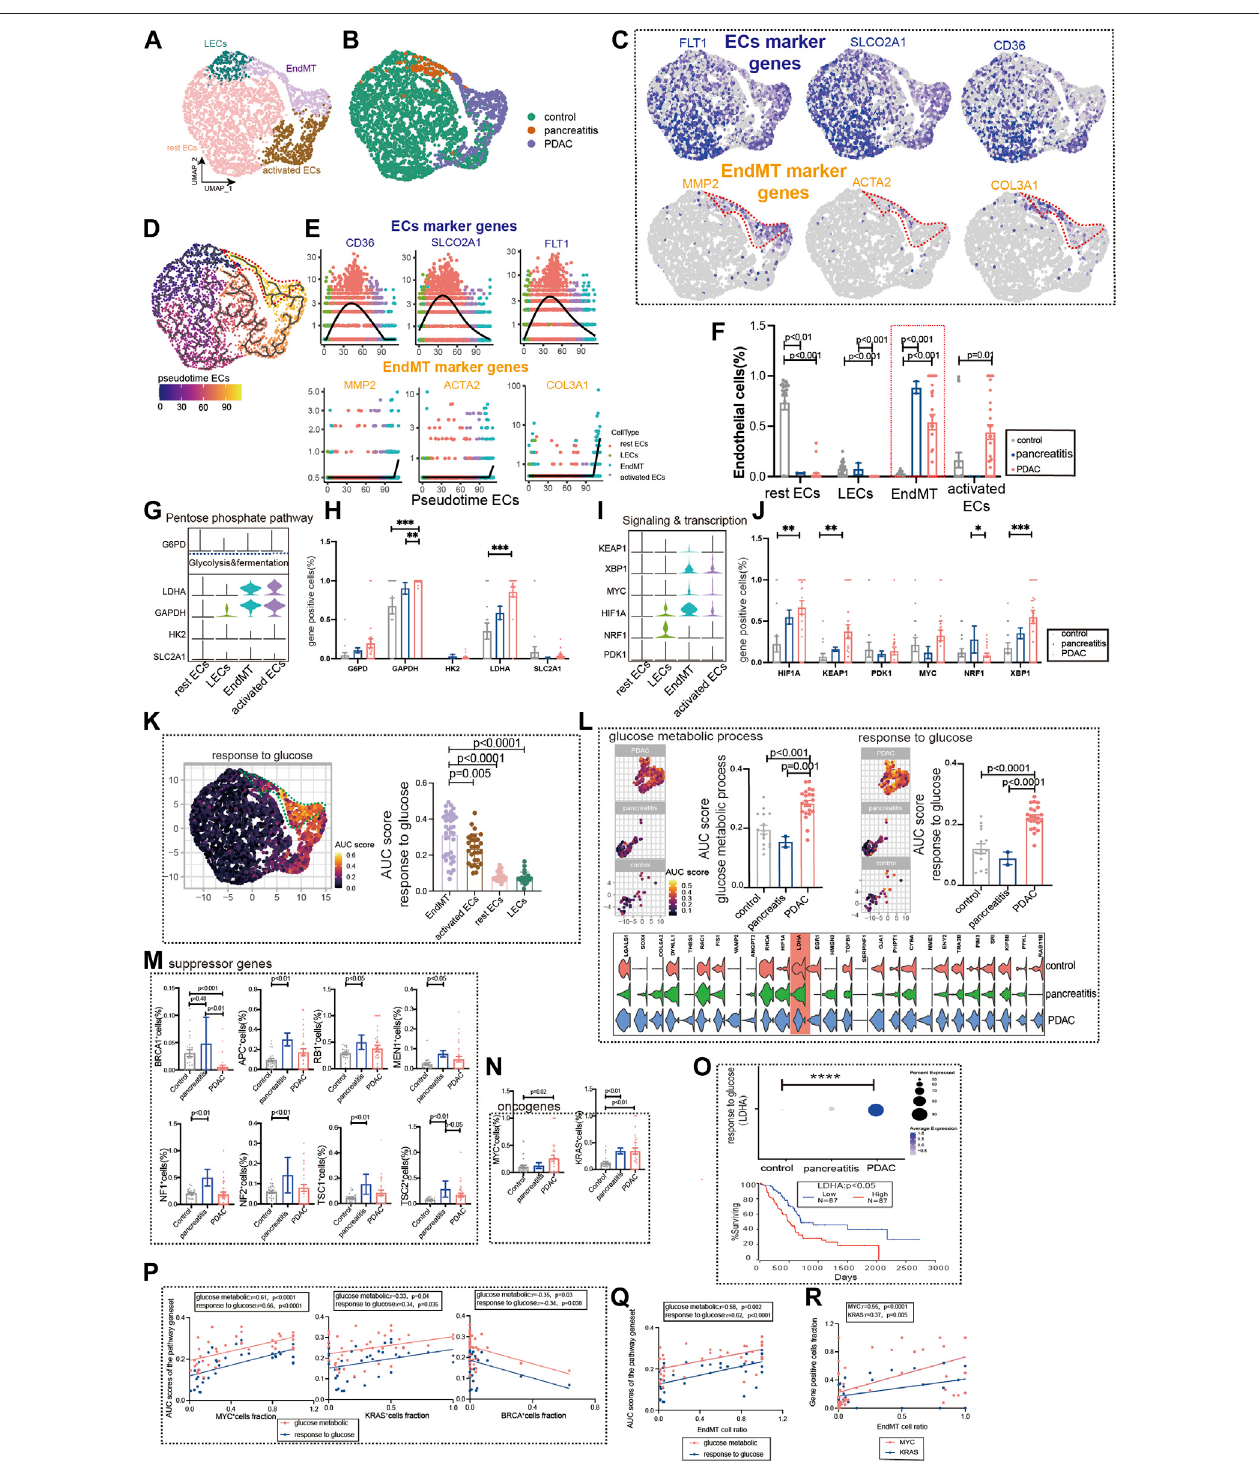
FIGURE 5 | Glucose metabolic status of EndMT in chronic pancreatitis and pancreatic cancer. (A, B) UMAP of 2,980 pancreatic ECs, from 21 control samples, 2 chronicpancreatitis,and30pancreascancer.Eachdotrepresentsasinglecell,andcellsarelabeledbycelltype. UMAPdemonstratesthecellularsubpopulationsofthe pancreatic ECs, including EndMT, activated ECs, rest ECs, and lymphatic ECs (see also Supplementary Table S2, S3 ). (C) UMAP plots show EC-speci fi c marker genes( FLT1 , SLCO2A1 ,and CD36 )and EndMT-speci fi cmarkergenes( MMP2 , ACTA2 ,and COL3A1 ). (D) Pseudotimeanalysisshowingthe evolutionary trendof ECs as “ rest EC-activated EC-EndMT. ” (E) Temporal variation of EndMT marker genes ( MMP2 , ACTA2 , and COL3A1 ),EC marker genes ( FLT1 , SLCO2A1 ,and CD36 ).